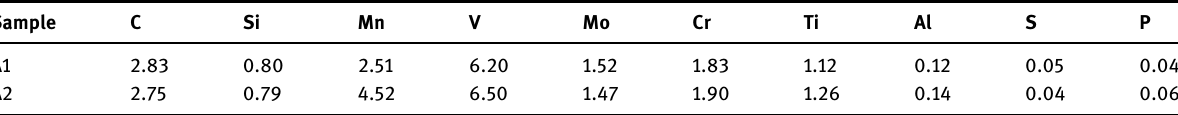
Table 1: Chemical compositions of experimental alloys ( wt% ) ( Fe balance ) Sample